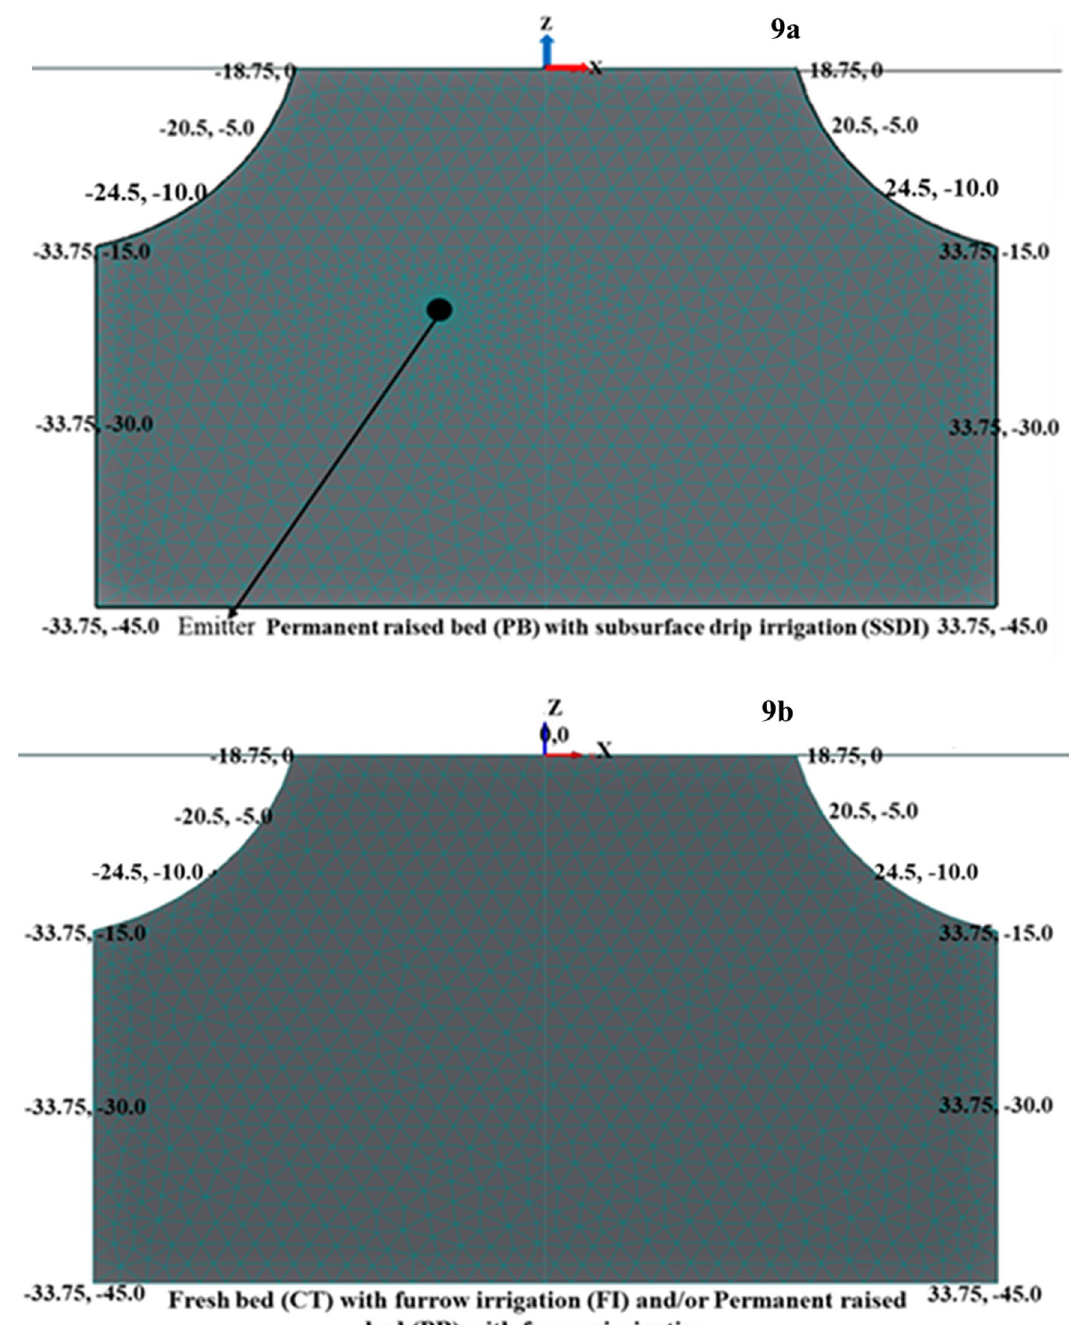
Figure 9. Geometries characterization of different land